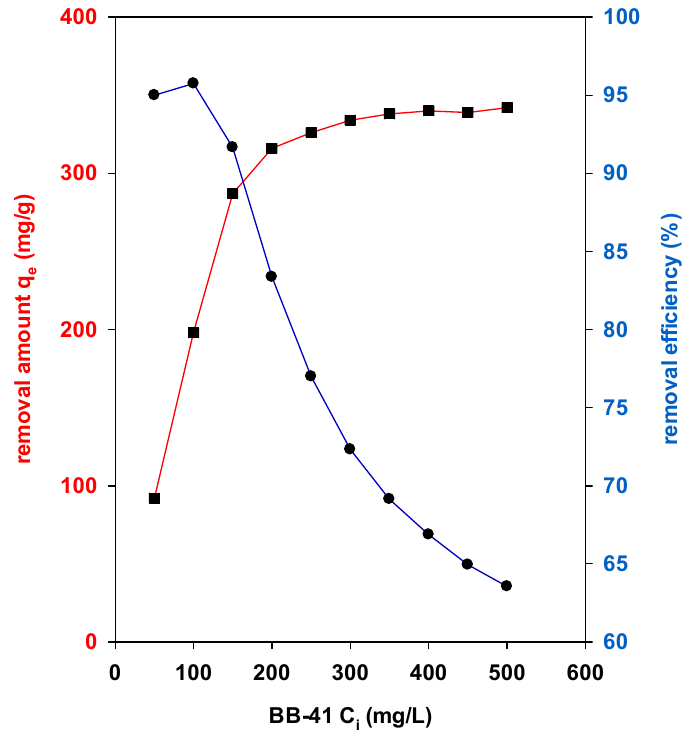
Figure 7. Effect of BB-41 initial concentration on the removal properties of Zr-PCH material (blue and red lines correspond to removal amount (mg/g) and removal percentage (%), respectively).